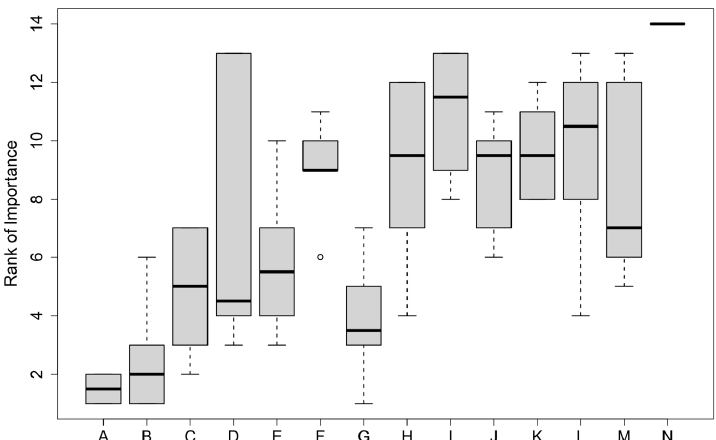
Figure 10. The relative importance of the 14 attributes used in this study. The lower the number, the higher the importance of the attribute. (A: Slope direction, B: Type of slope, C: % Organic, D: Elevation, E: Distance to road, F: % Sand, G: Sub- watershed, H: % Clay, I: Slope class, J: Lithology, K: Distance to river, L: Average annual rainfall, M: % Silt, N: Epoch).